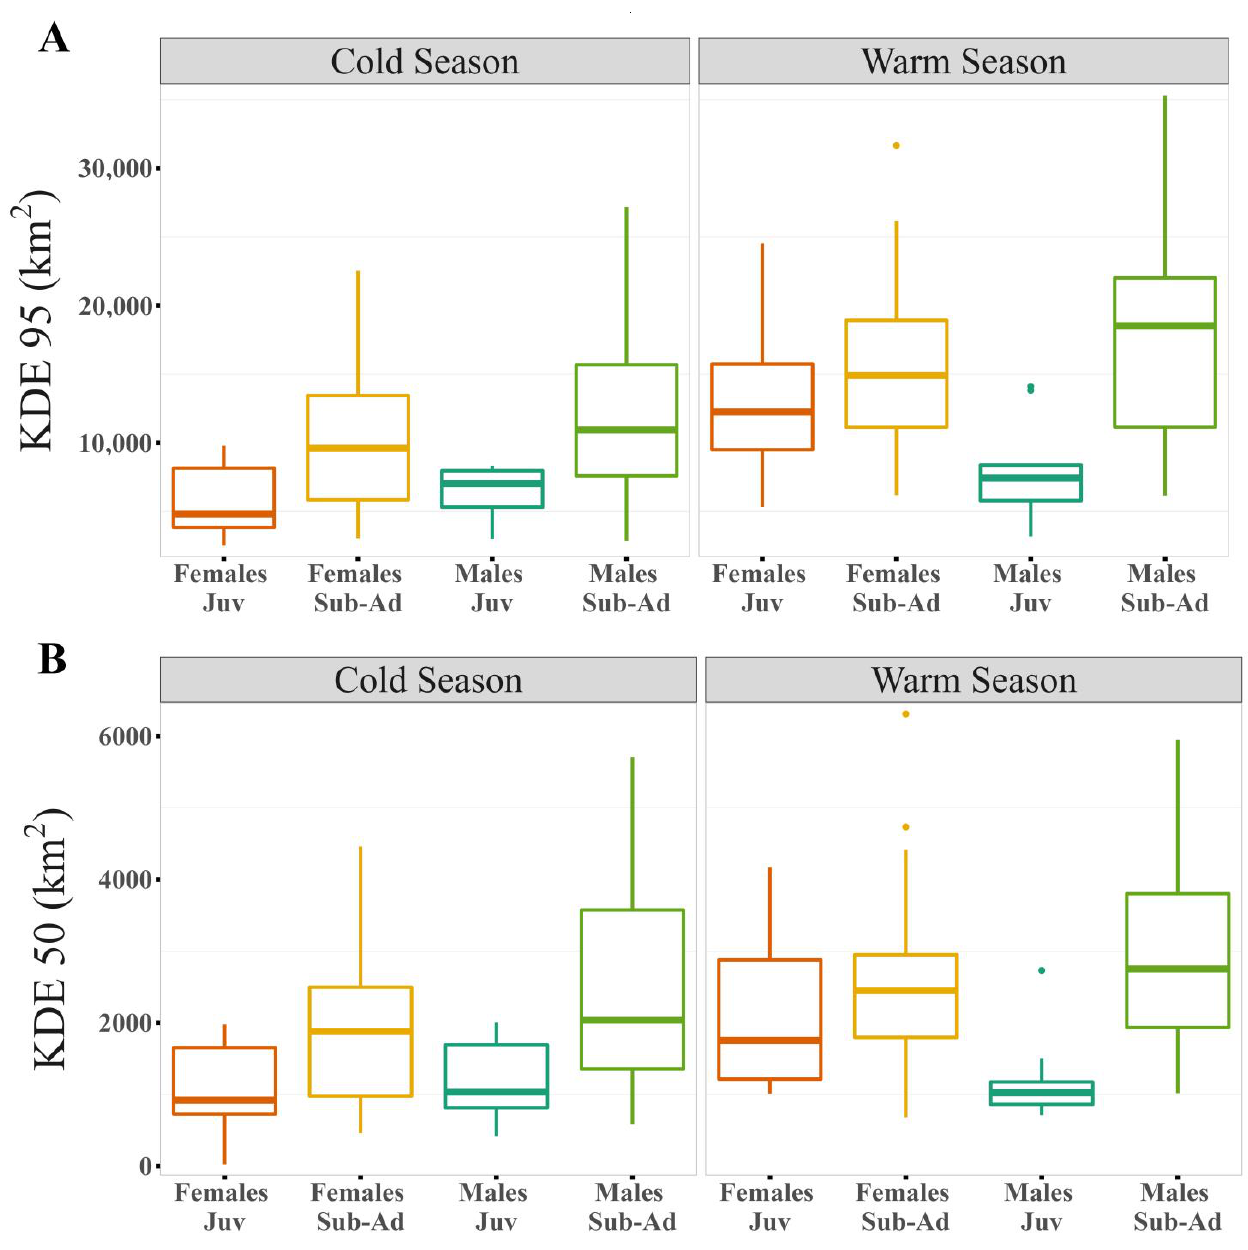
Figure 3. Differences between sexes and ages by season for the logarithm of the different estimators: ( A ) Kernel Density Estimator (KDE) of 95% and ( B ) Kernel Density Estimator (KDE) of 50% of the contour area.